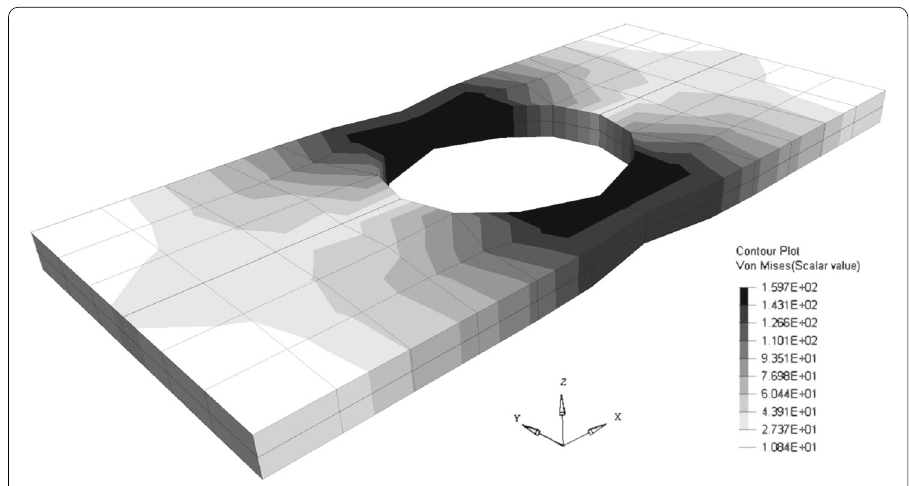
Fig. 3 Von Mises constraints for the pierced plate in traction final configuration